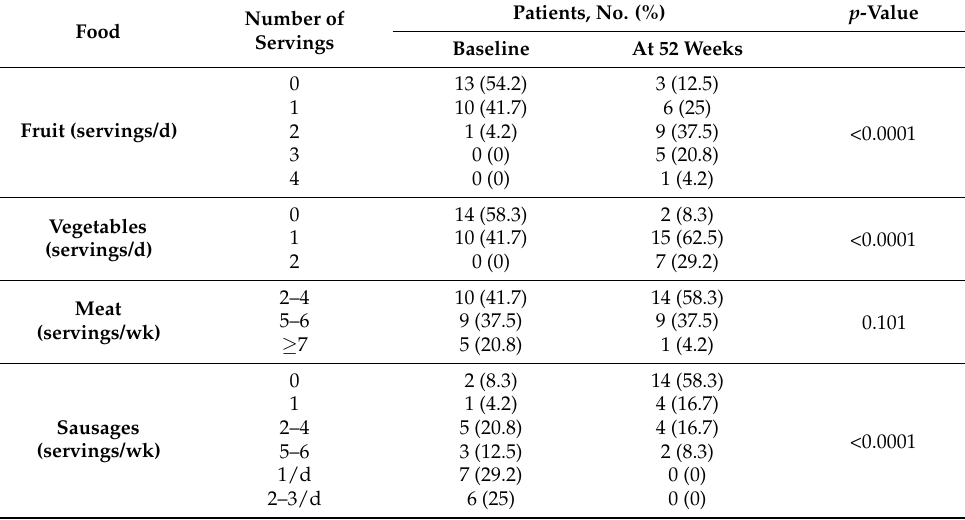
Table 3. Intake by food group upon starting the CDED and at 52